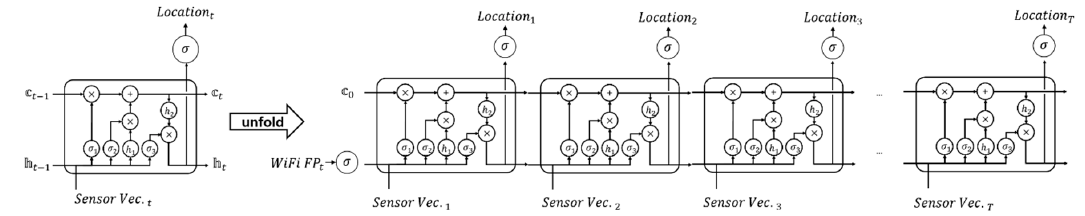
Figure 7. Structure of the middle layer.